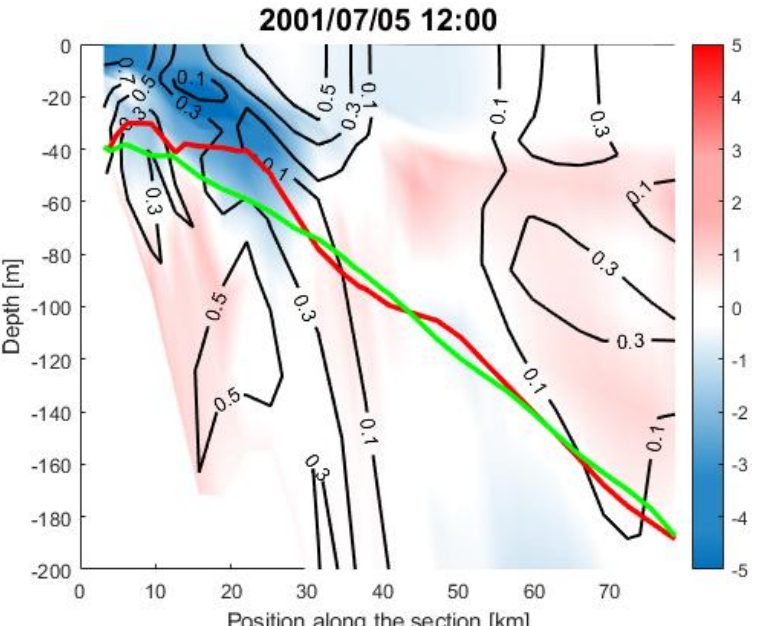
Figure 6. Depth-averaged, 42-h low-passed ocean current in black arrows and 42-h low-passed SST with tidal forcing ( left panels, a-c, g-i ). Corresponding results but retrieved from 6 simulations without tidal forcing during 6 typhoon passages are shown in right panels (d-f, j-l ). Additionally marked is 10-m wind in white arrows (scaled in bottom-right corners). White line in Figure 6a denotes the location of the zonal transect shown in Figure 7.